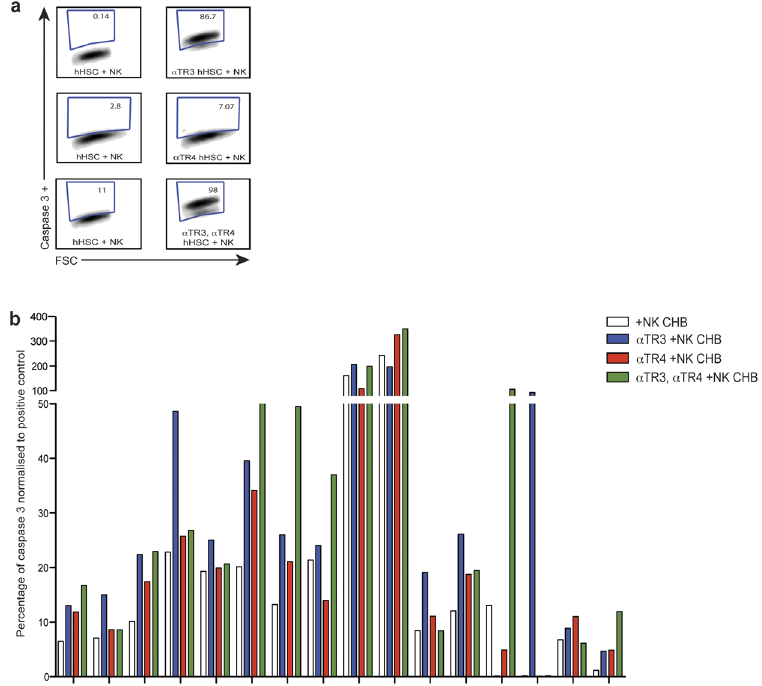
Figure 4. Blocking TRAIL-R3/4 on hHSC increases their susceptibility to NK cell mediated apoptosis. ( a ) FACS plots of induction of apoptosis (caspase3 + ) in hHSC co-cultured with NK cells from patients with hepatitis B with or without TRAIL-R3 or TRAIL-R4 blockade. ( b ) Percentage apoptosis of hHSC with an isotype blocking mAb (white) or with mAb blocking TRAIL-R3 ( α TR3, blue), TRAIL-R4 ( α TR4, red) or combination of α TR3 and α TR4 (green bars) upon NK cell co-culture. Responders whose NK cells induced > 5% more apoptosis of hHSC with one or more strategy are shown, with %caspase3 induction normalised to the positive control ( SuperKiller TRAIL) to adjust for inter-donor hHSC